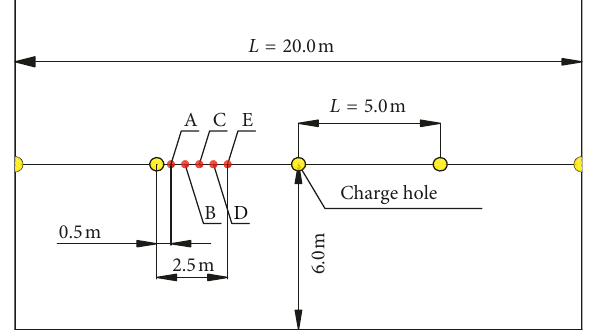
Figure 11: Model size and layout of observation points.